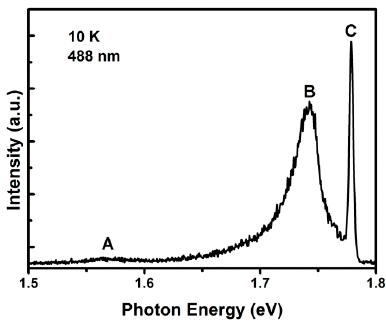
Figure 1. Low-temperature (10 K) photoluminescence (PL) spectrum of GaTe single crystals.